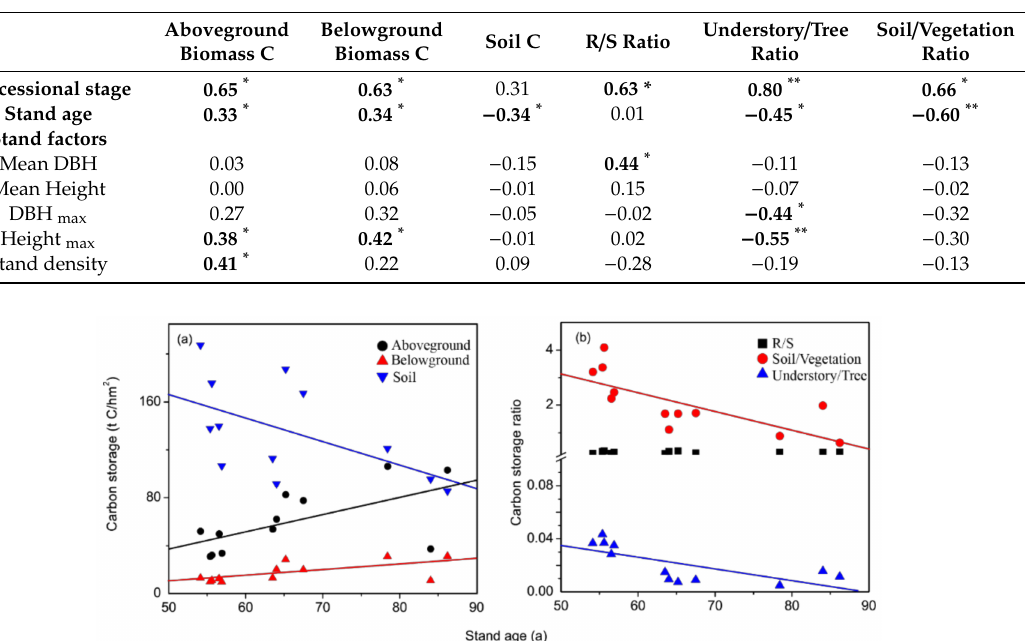
Figure 2. Relationship of carbon storage and allocation with stand age. ( a ) Carbon storage, ( b ) Carbon storage